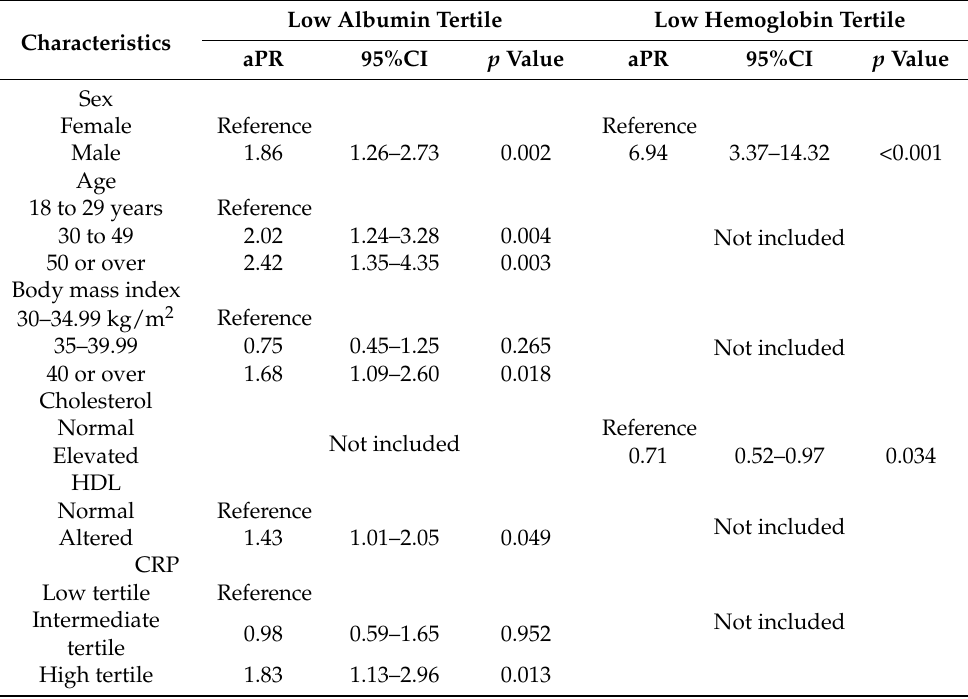
Table 4. Generalized linear models of the Poisson family with the log link function and robust variances to evaluate the factors associated with nutritional deficit markers in the study